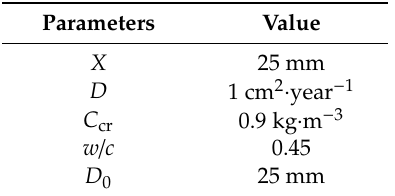
Table 3. Parameters for corrosion simulation.